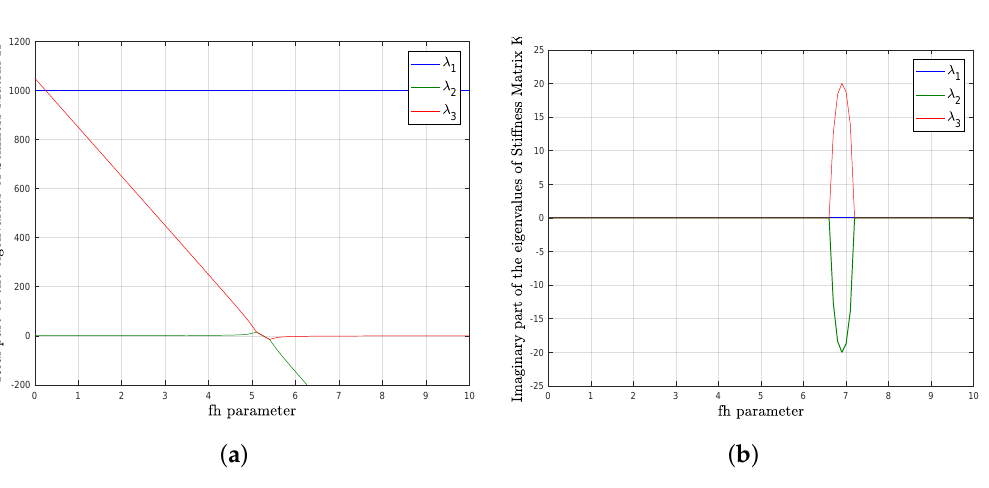
Figure 2. Eigenvalues of stiffness matrix K for K 2 / K 3 = 100 and a / L = 1. ( a ) Real part of the eigenvalues; ( b ) imaginary part of the